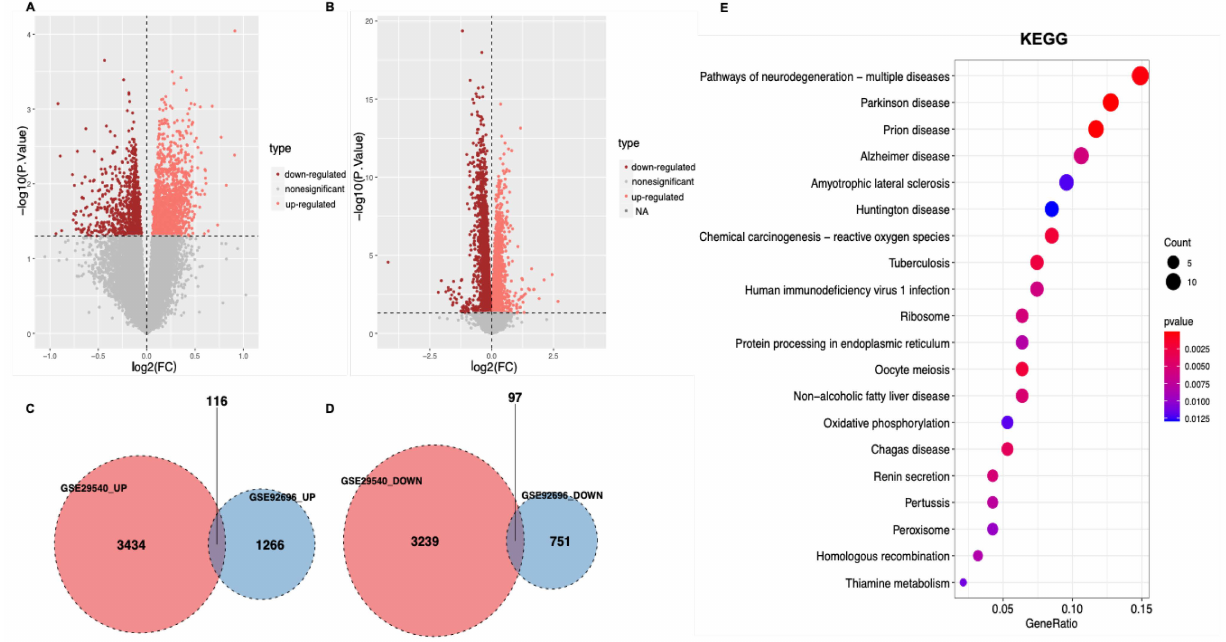
Figure 1. Identification of DEGs and enrichment analysis of the DEGs. ( A ) The volcano plot of GSE29540. The orange points show upregulated genes, and the coffee-colored points represent downregulated genes. ( B ) The volcano plot of GSE92696. ( C , D ) Venn diagrams of the number of upregulated ( C ) or downregulated ( D ) DEGs in both datasets. ( E ) KEGG analysis of overlapping DEGs. The top 20 terms are displayed. p -value < 0.05 was set as the critical